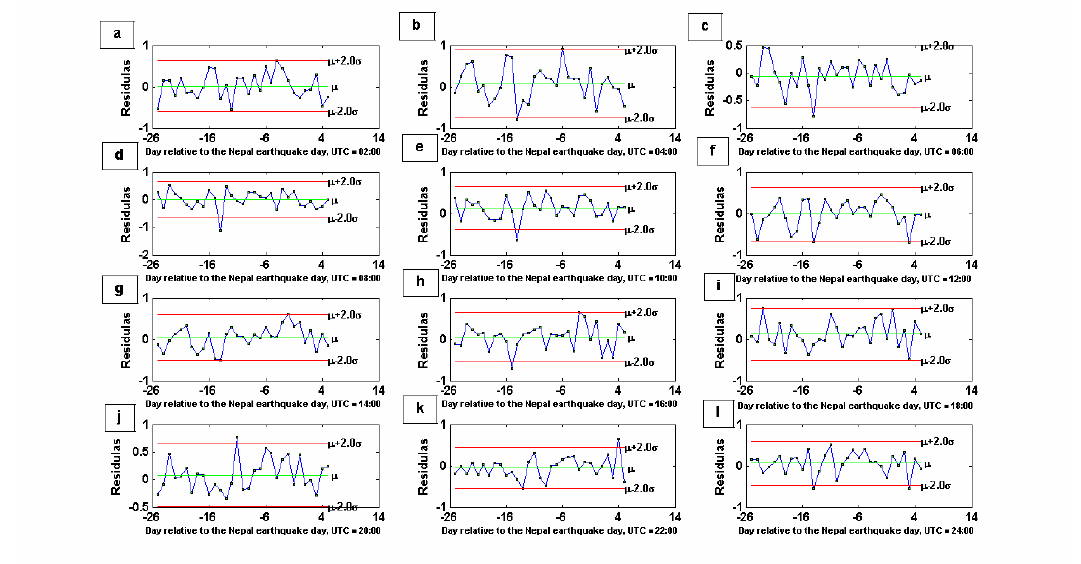
Fig. 4. a) through l) Variations of the differences between the observed and the predicted values of TEC obtained from ANN method on days selected as testing set at different universal times. The red horizontal lines indicate the upper and lower bounds ( σµ ×± 2 ). The green horizontal line indicates the mean value ( µ ). The X-axis represents the day relative to the Nepal earthquake day.